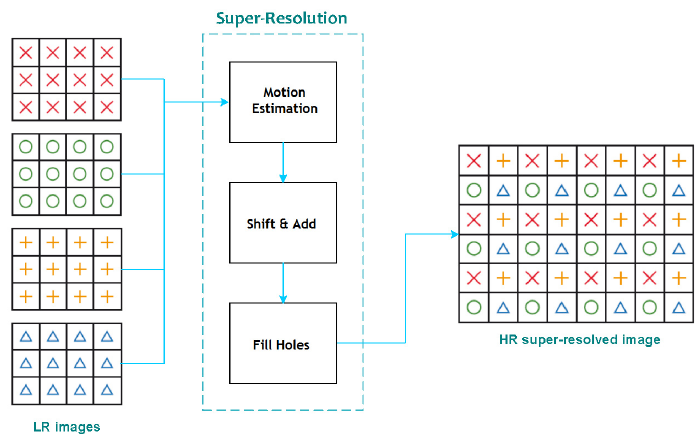
Figure 8. General diagram of the super-resolution approach